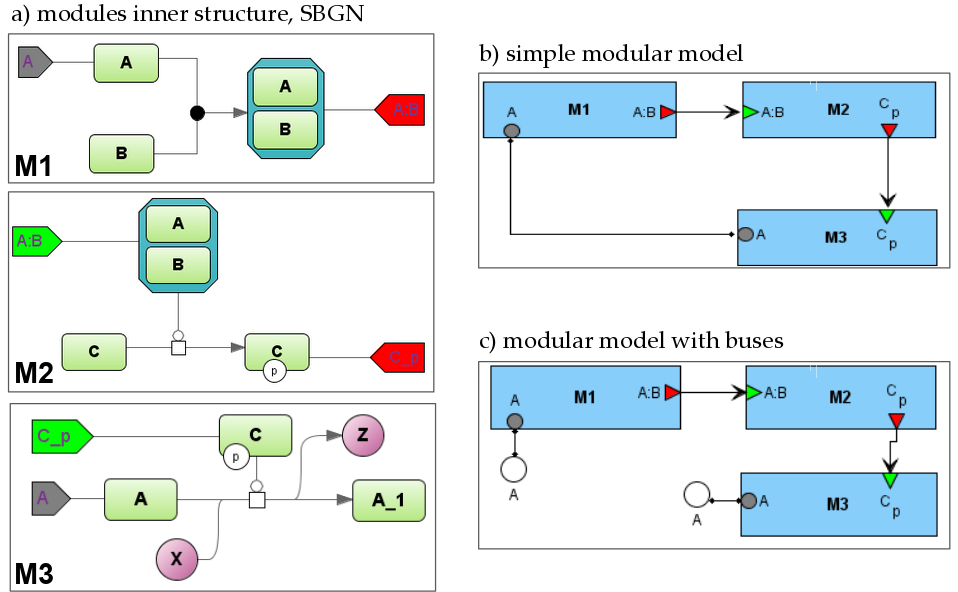
Figure 1. Modular model example. ( a )—inner structure of modules (SBGN). M1-M3 designate corresponding modules; two green rectangles A and B in M1 correspond to molecules A and B which form the complex A:B, while grey and red pentagons in M1 designate contact port for A and output port for A:B, respectively; two green rectangles C and C_p in M2 correspond to protein C and phosphorylated form of the protein, while green and red pentagons in M2 designate input port for A:B and output port for C_p, respectively; two green rectangles A and A_1 in M3 correspond to molecules A and A_1, while green and grey pentagons in M3 designate input port for C_p and contact port for A, respectively; two purple circles X and Z in M3 mean the additional substrate and product of the bimolecular reaction, correspondingly that is catalyzed by phosphorylated form of the protein C (green rectangle), ( b , c )—modular diagram in two equivalent variants: without or with buses (white circles). Buses serve for cosmetic purposes only.